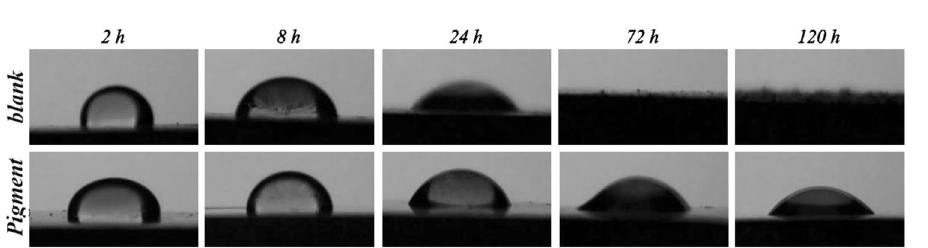
Figure 8. The contact angle images of the distilled water droplet placed on the AA2024-T3 surface soaked in 3.5 wt.% NaCl solution (blank) and extract solution of the Ce-DEDTC pigment (Pigment) after various immersion times.